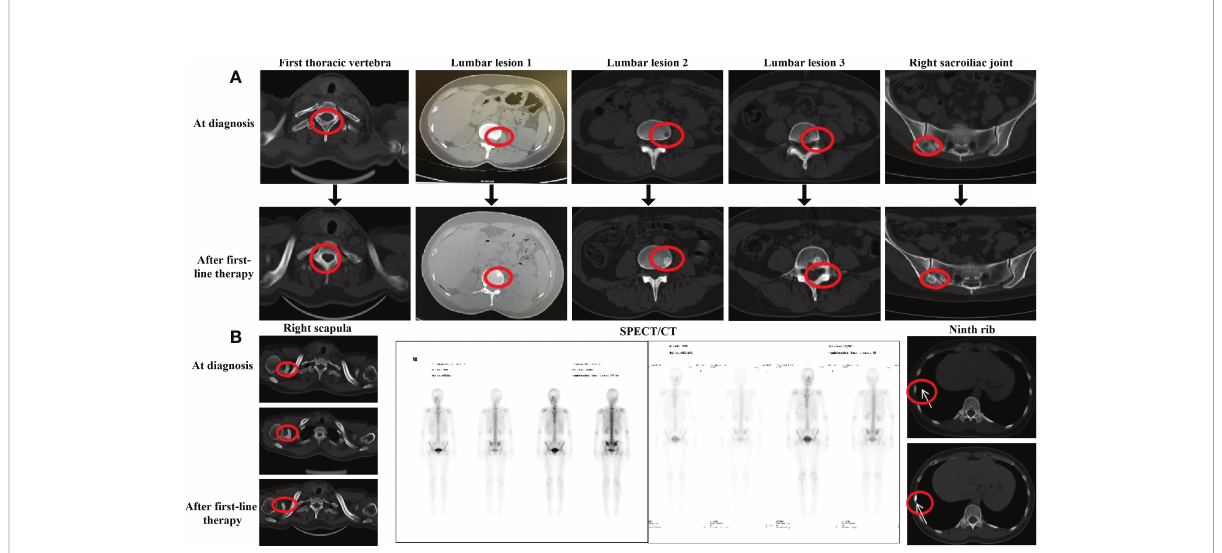
FIGURE 1 Evaluation after fi rst-line endocrine therapy (A) CT evaluation of the bons lesion after fi rst-line endocrine therapy in September 2020. (B) CT evaluation of right scapula the ninth rib and SPECT evaluation after fi rst-line endocrine therapy in September